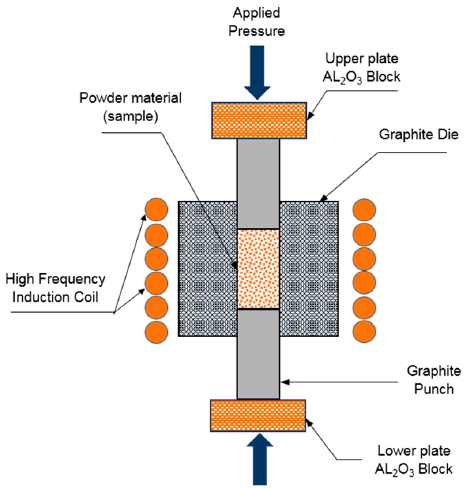
Figure 3. Schematic diagram of high-frequency induction heated sintering apparatus.